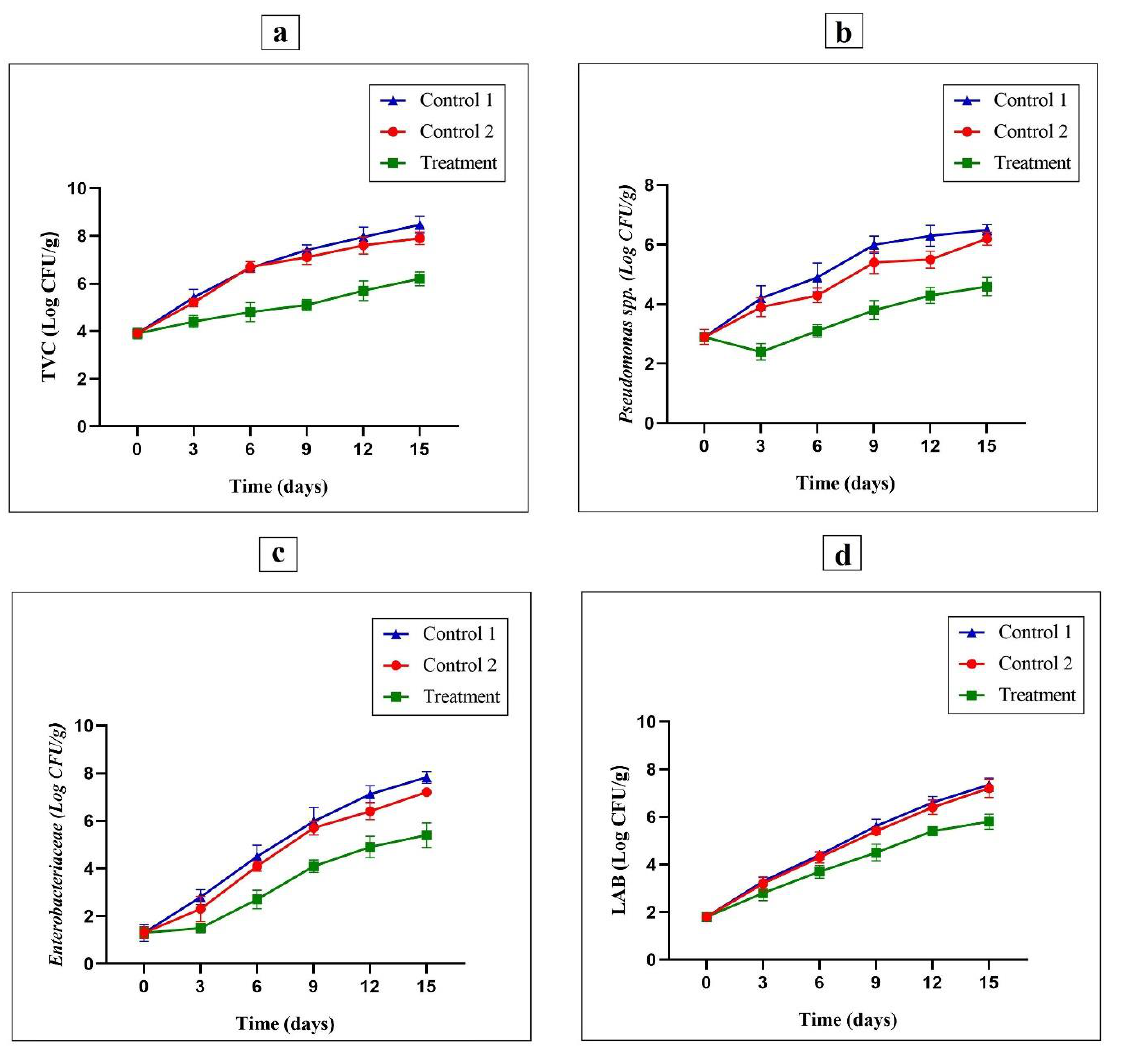
Figure 4. The antimicrobial effects of G/PVA/MEO/CWE films (as treatment), PE films (Control 1) and G/PVA films (Control 2) against TVC ( a ), Pseudomonas spp. ( b ), Enterobacteriaceae ( c ), and LAB counts ( d ) in in the raw turkey breast meat during 15 days of the storage in refrigeration at 4 °C.